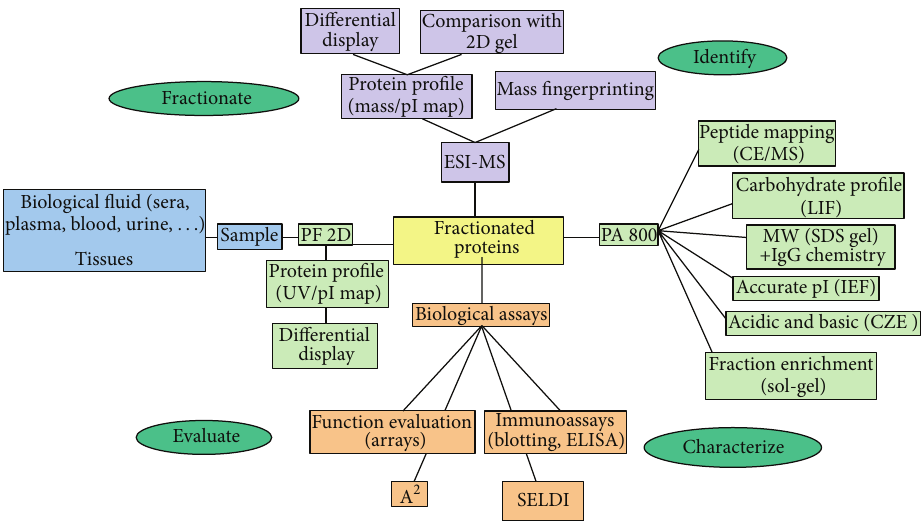
Figure 1: Schematic diagram of protein biomarkers from identification to